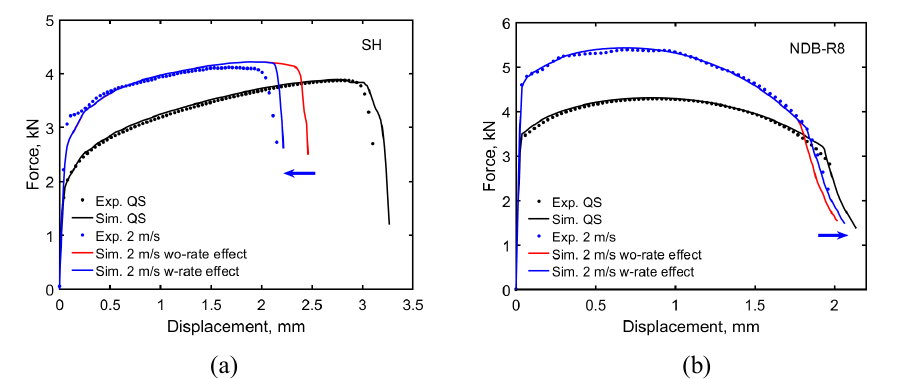
Fig. 11. Force-displacement curves from experiments and the simulations at different loading speeds for different geometries. (a) SH; (b)